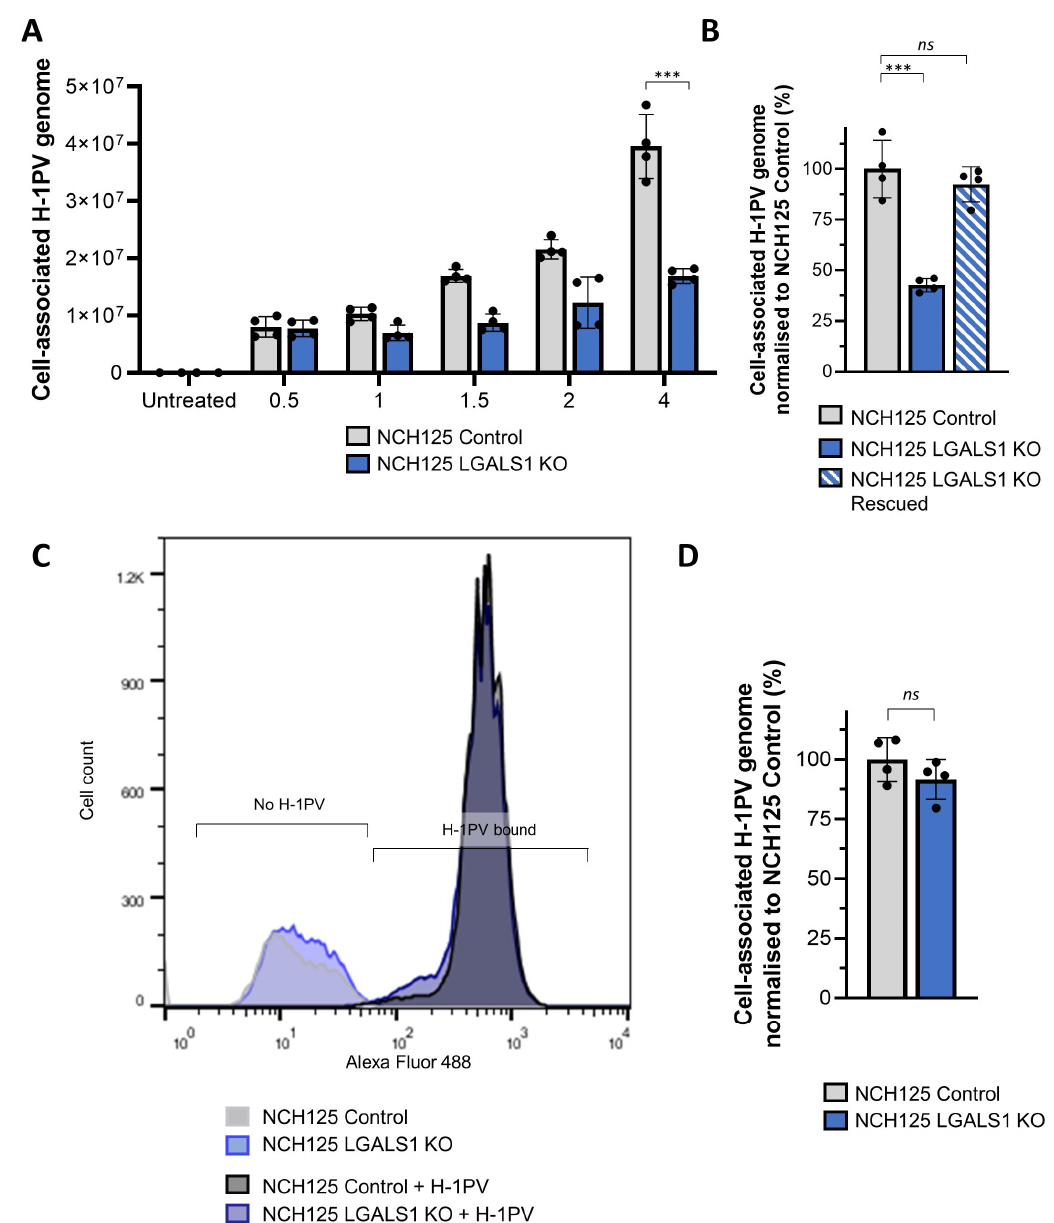
Figure 5. H-1PV cell entry, but not cell attachment, is reduced in NCH125 LGALS1 KO cells. ( A ) H- 1PV binding and entry assay assessed by qPCR. NCH125 Control and LGALS1 KO cells were infected with H-1PV at an MOI of 5 pfu/cell for 0.5, 1, 1.5, 2 and 4 h at 37 °C. Cells were then extensively washed and harvested, and encapsidated viral DNA was extracted and subjected to qPCR. Columns in the graph show the number of copies of the cell-associated H-1PV genome with relative standard deviations (*** p ≤ 0.001). The independent experiment shown was repeated thrice; n = 3 biologically independent samples. ( B ) Binding and entry is rescued by the addition of purified recombinant Gal-1. At the time of H-1PV infection (at an MOI of 5 pfu/cell), Gal-1 was added (or not) to the culture medium. Infection was carried out for 4 h. Numbers indicate the percentage of cell-associated genomes relative to NCH125 Control cells infected with H-1PV arbitrarily set as 100% The independent experiment shown was repeated twice each with four biologically independent samples ( ns: p > 0.05; *** p ≤ 0.001, calculated using a one-way ANOVA). ( C ) H-1PV cell surface binding assessed by Flow cytometry. A representative flow cytometry histogram with overlay of Control (black) and LGALS1 KO cells (blue) shows no difference in H-1PV-associated cells. Cells were either mock- or H-1PV-infected (at an MOI of 25 pfu/cell) for 1 h at 4 °C. Cells were not permeabilised for the Flow cytometry analysis, and cell surface-bound H-1PV particles were detected with a specific anti-capsid